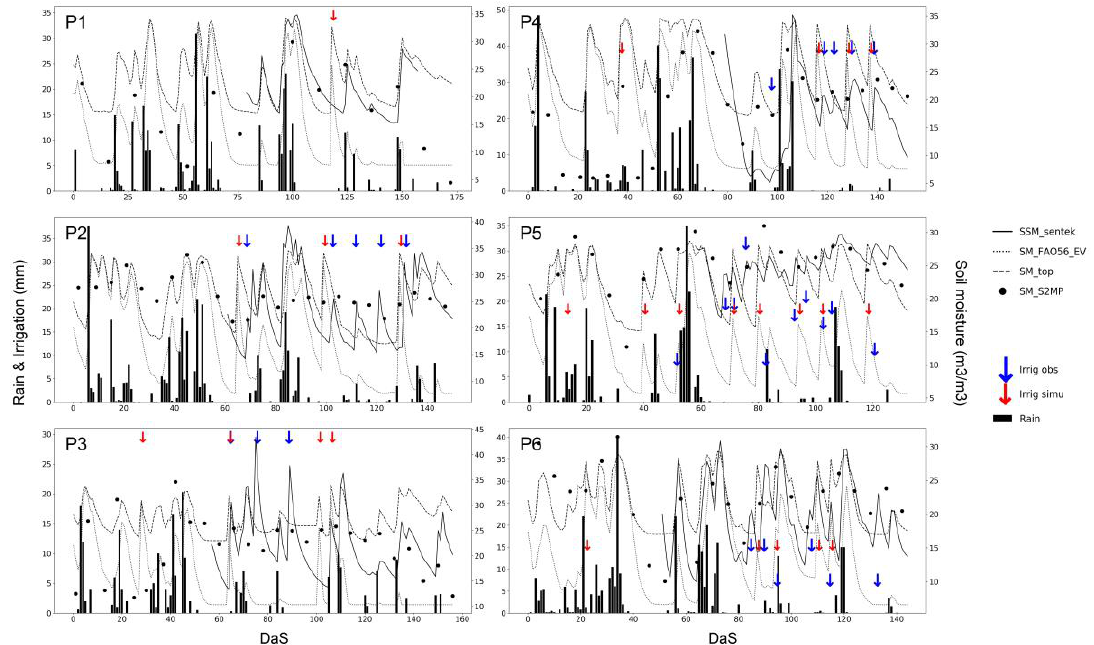
Figure 6. Irrigation detection for six plots using the S 2 MP product. The soil moisture variables are shown as volumetric percentages (right axis). Rainfall and irrigation events are given in millimeters (left axis). The scale on the horizontal axis corresponds to the number of days since sowing.